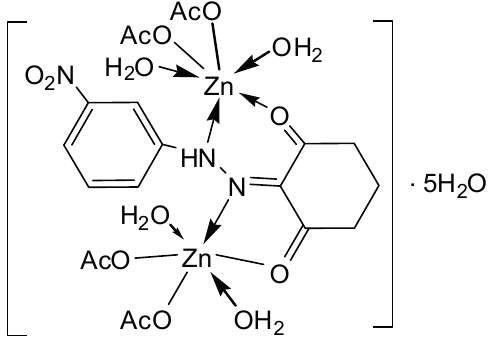
Figure 9. Structure of [Zn 2 (L 2 )(OAc) 4 (H 2 O) 4 ]·5H 2 O